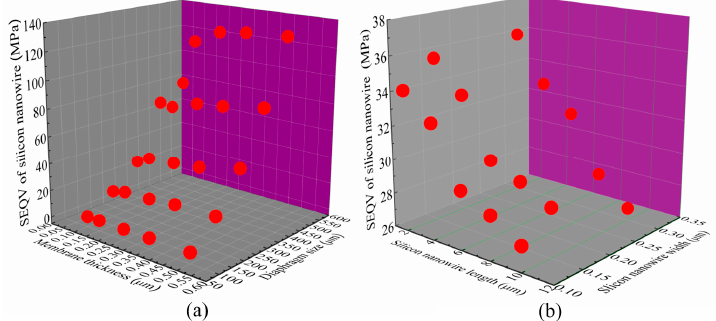
Figure 3. ANSYS simulation results: ( a ) the von Mises equivalent stress (SEQV) of double SiNW of 2 µm length vs. diaphragm size and membrane thickness; and ( b ) SEQV of double SiNW vs. the length and width of double SiNW.